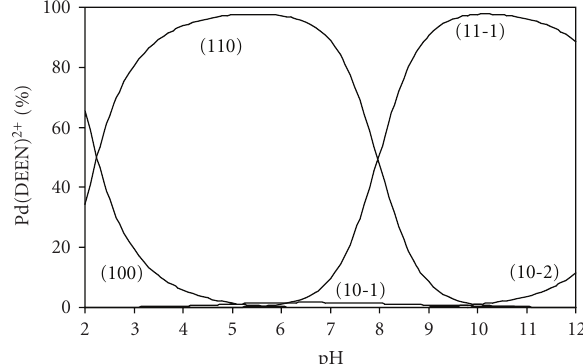
Figure 2: Concentration distribution diagram for various complex species in Pd(DEEN) 2+ -serine